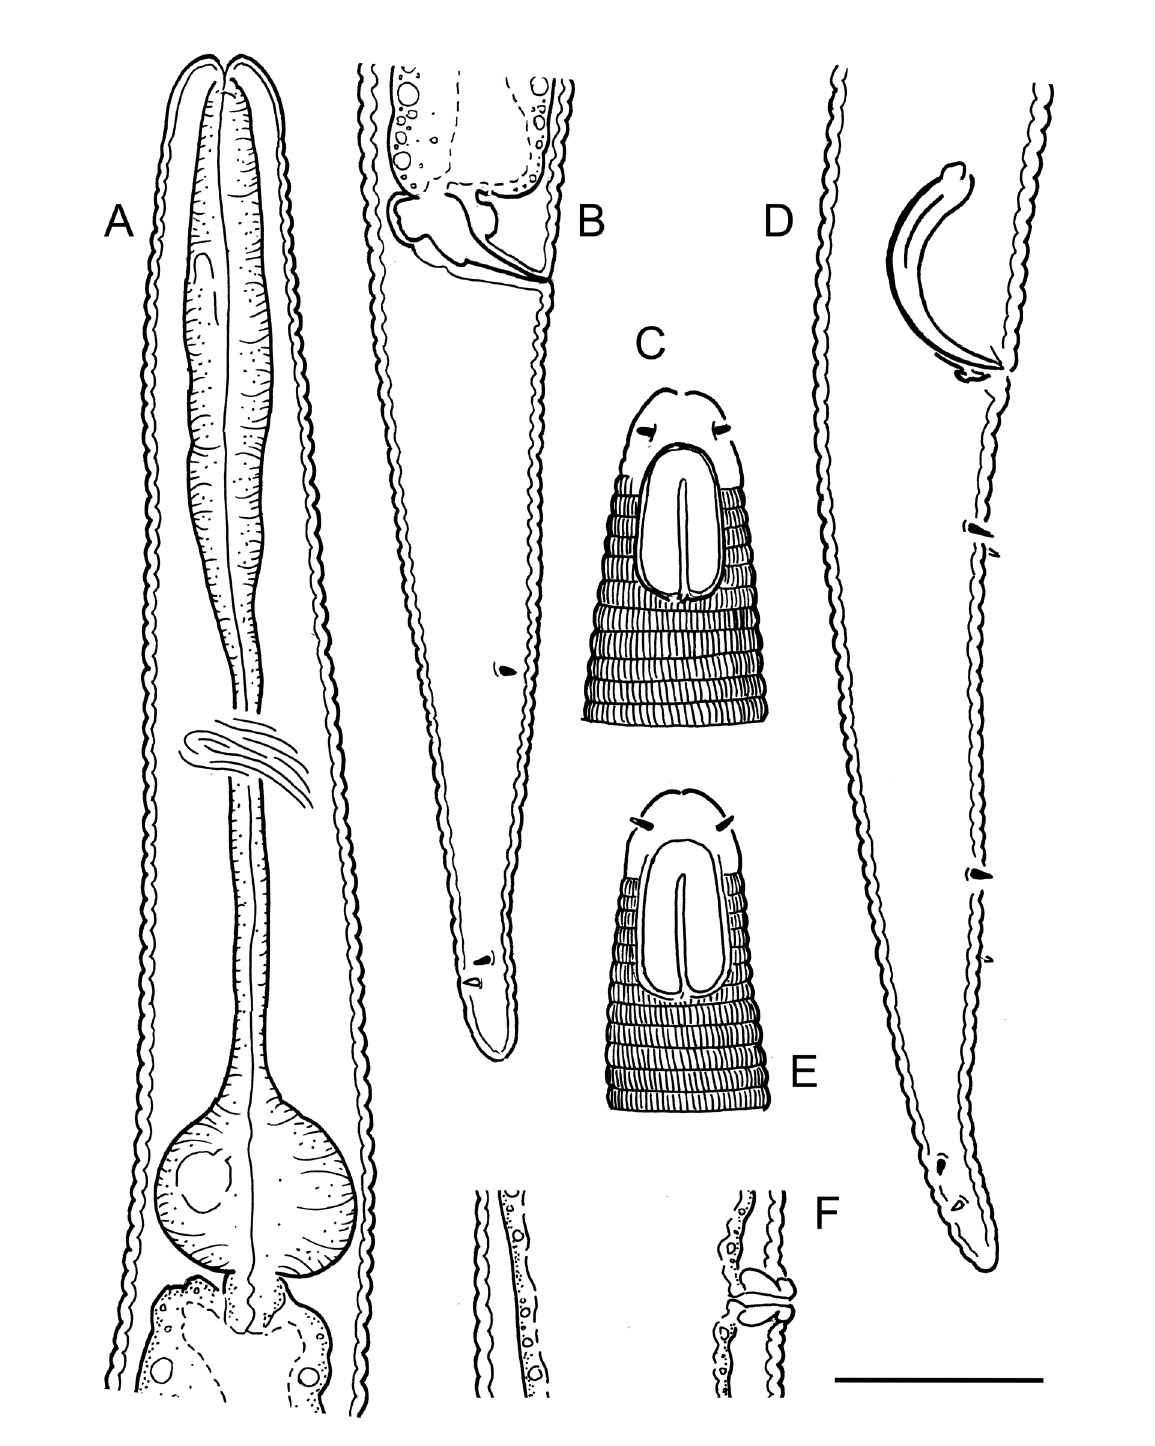
Fig. 8. Diplopeltoides pumilus (Vincx & Gourbault, 1992) comb. nov. A . Female pharyngeal region, optical median section. B . Female tail. C . Female anterior end, surface view. D . Male tail. E . Male anterior end, surface view. F . Vulval region. Scale bar = 20